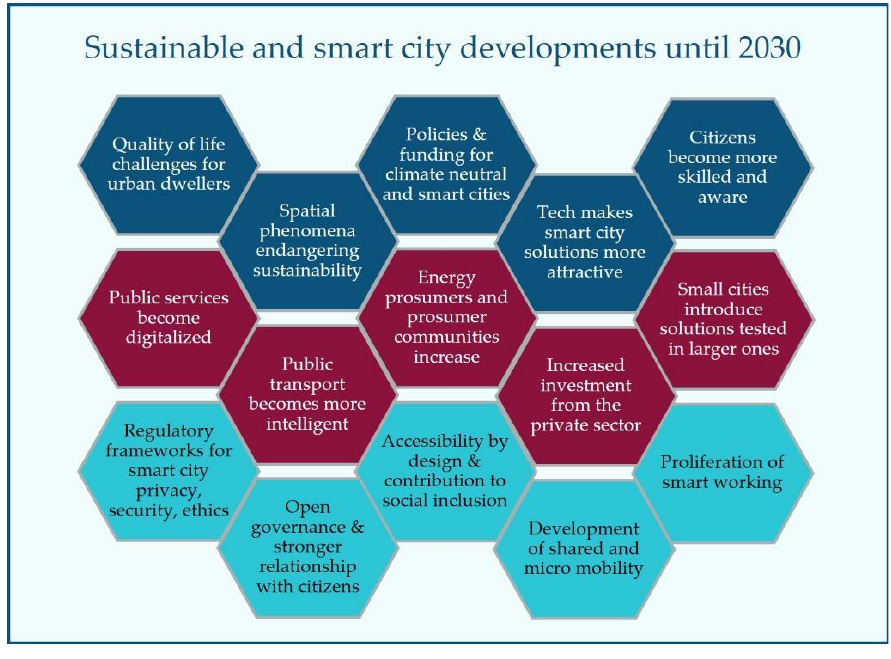
Figure 3. Emerging developments in sustainable and smart cities through 2030 (authors).